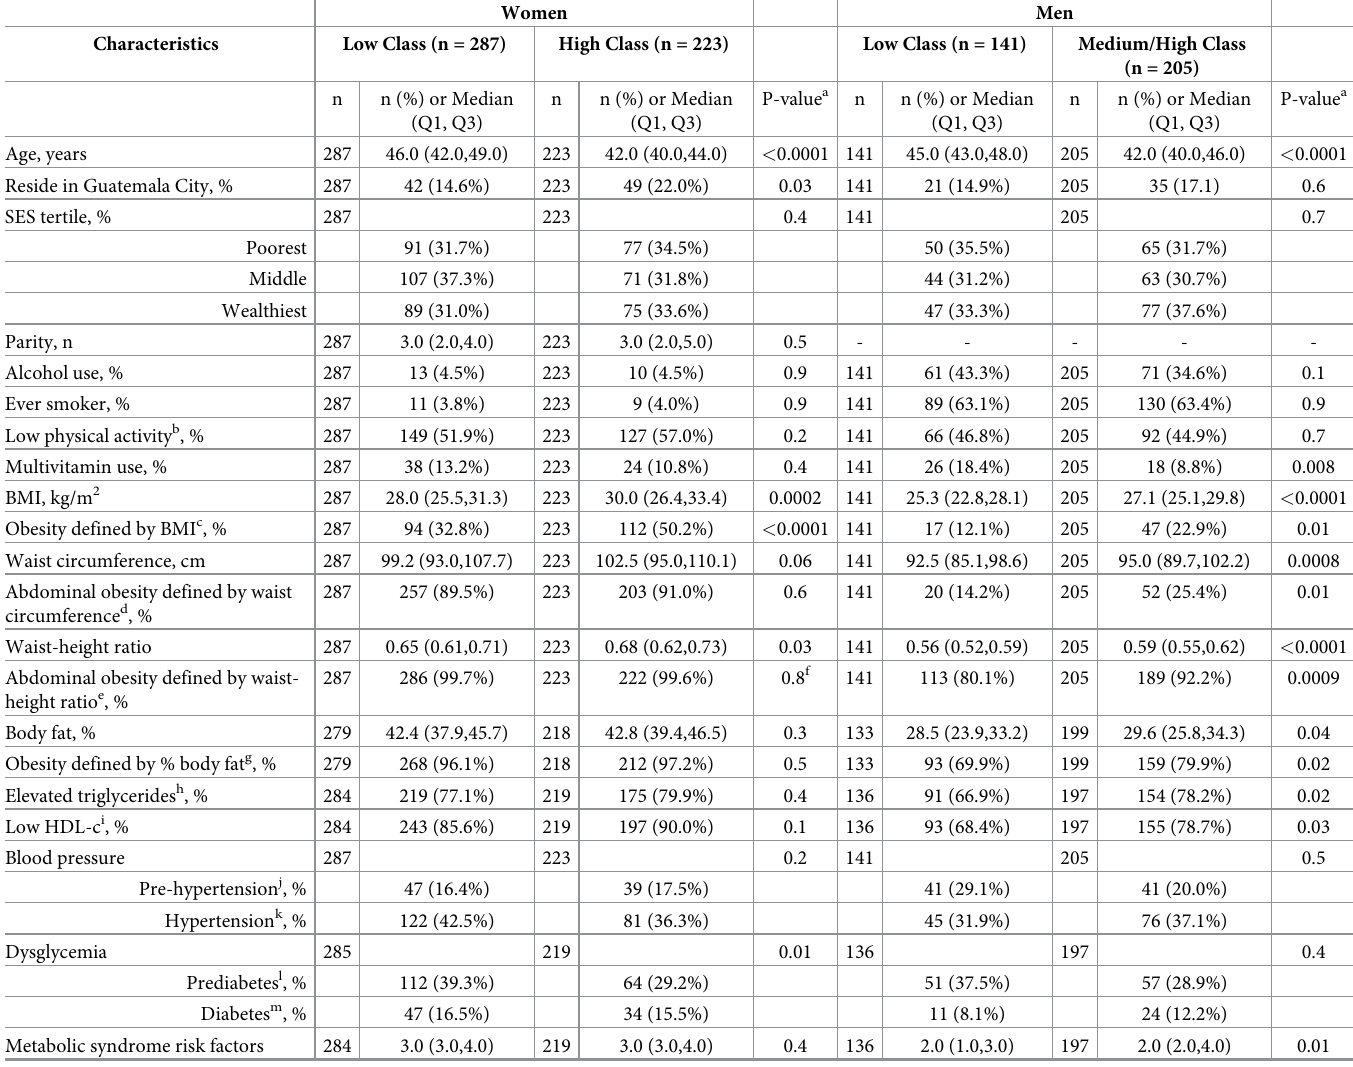
Table 1. Select sociodemographic and health characteristics in 2015–17 after 40 years of follow up at age 37–54 years by BMI latent class trajectory and sex, INCAP nutrition supplementation trial longitudinal cohort (n = 510 women, n = 346 men). Women